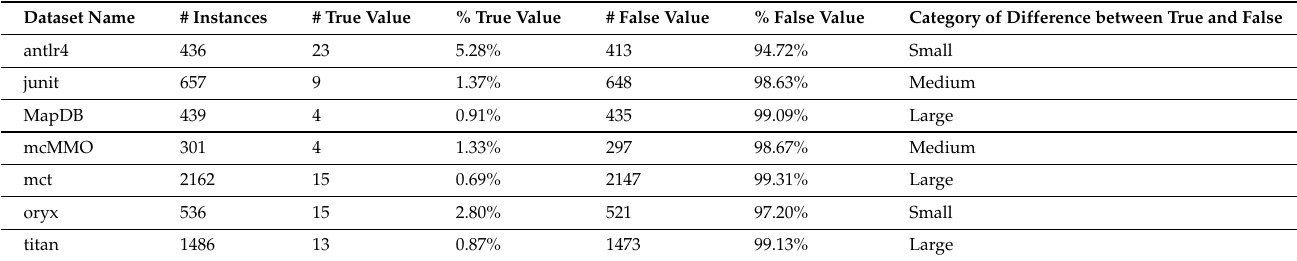
Table 5. Number of true and false values in the change-proneness